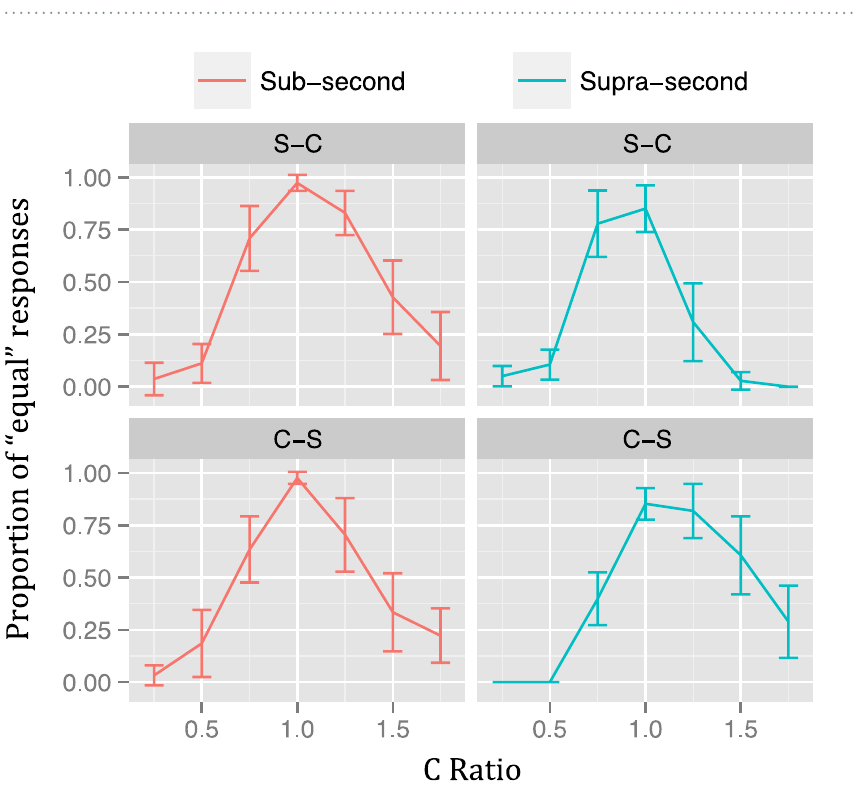
Figure 3. Temporal generalization gradients of Experiment 1 (linearly spaced ratios) by presentation order. Proportion of “equal” responses for the Sub-Second (left) and Supra-Second (right) conditions by presentation order. Vertical lines represent 95% confidence